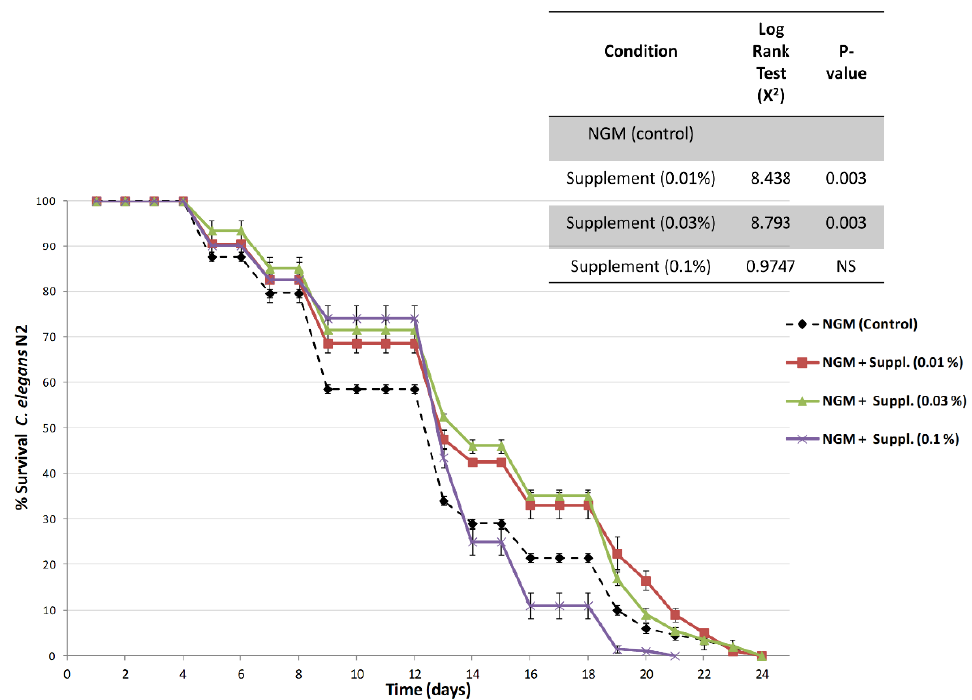
Figure 6. Survival curves (percentage of survival) obtained in C. elegans (N2) cultured in nematode culture plates (NGM) or in NGM with different doses of the supplement. Data are the average of two independent experiments.